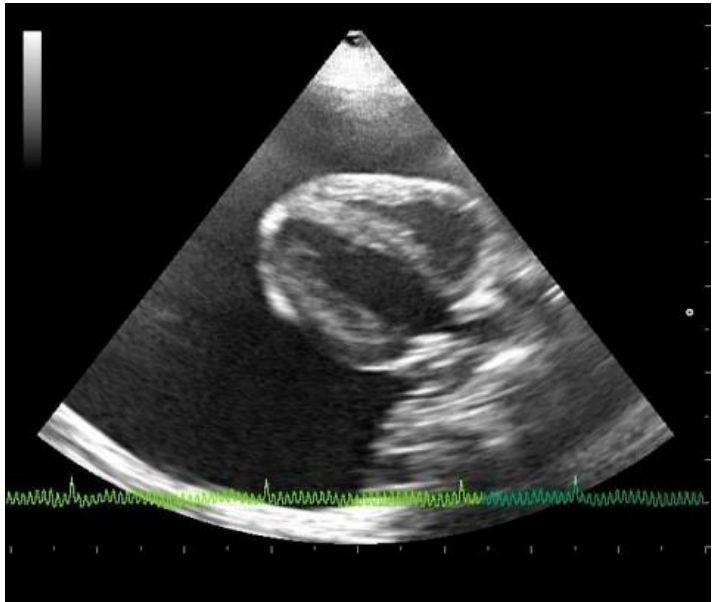
Figure 2. Echocardiographic right parasternal B-mode evaluation (four chambers view) showing the presence of severe pericardial effusion.